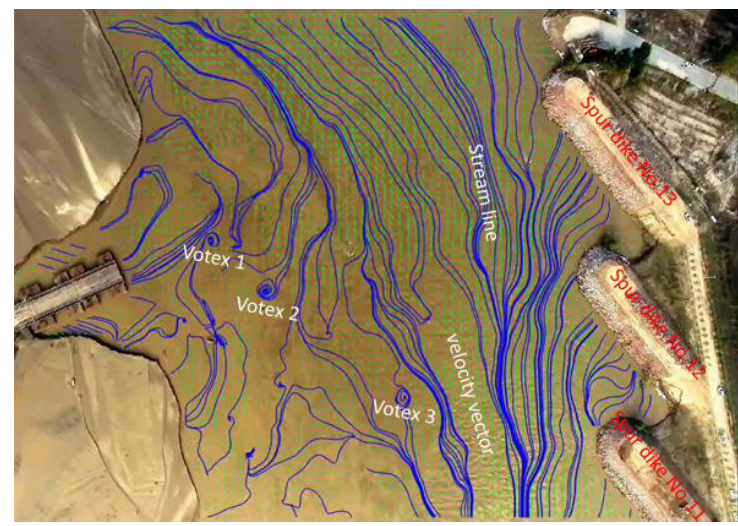
Figure 1. Surface flow field of the Heigangkou downstream extension project.